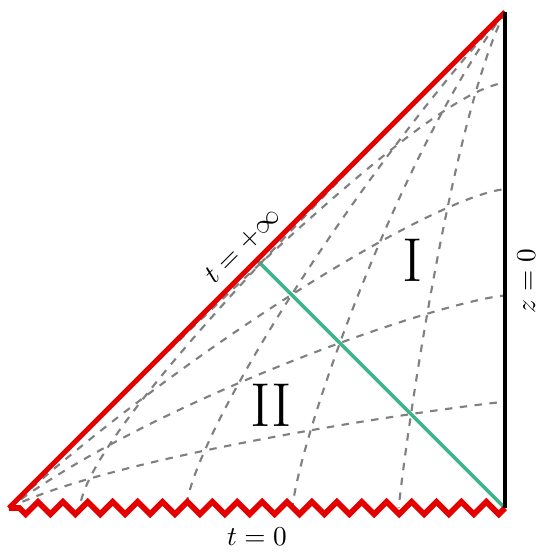
Figure 3 . The causally reconstructible region I is separated from region II by the scale invariant t = z